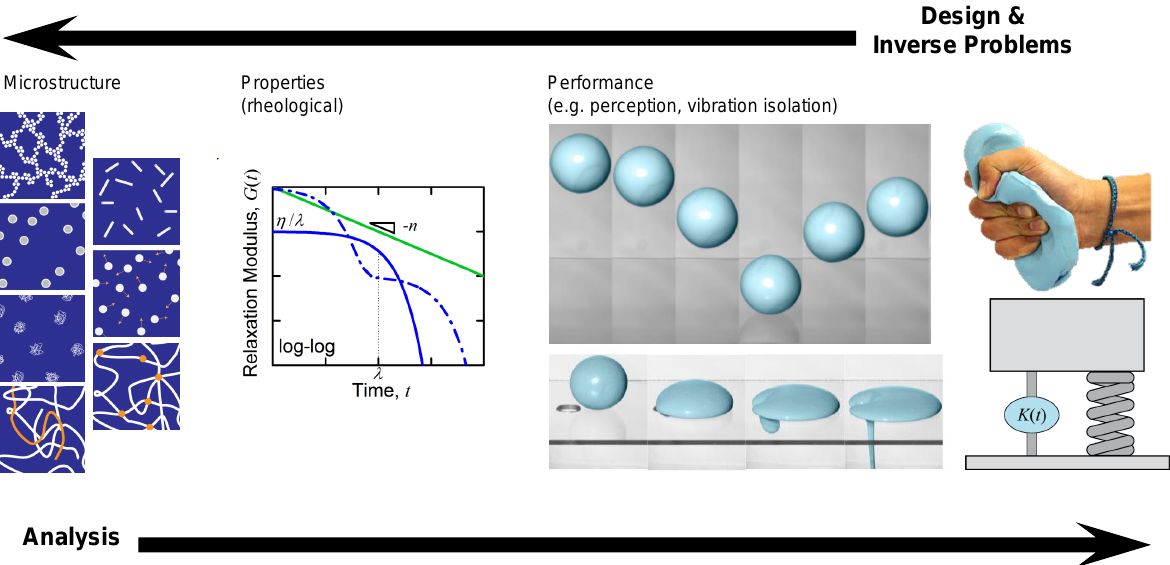
Figure 3: Engineering design is an inverse process with multiple options to meet an objective. Function-valued rheological properties are at the center of this structure-properties-performance design paradigm (adapted from [43]). Our work here aims to improve design intuition for linear viscoelastic materials by simplifying property representations and improving the mapping of properties to